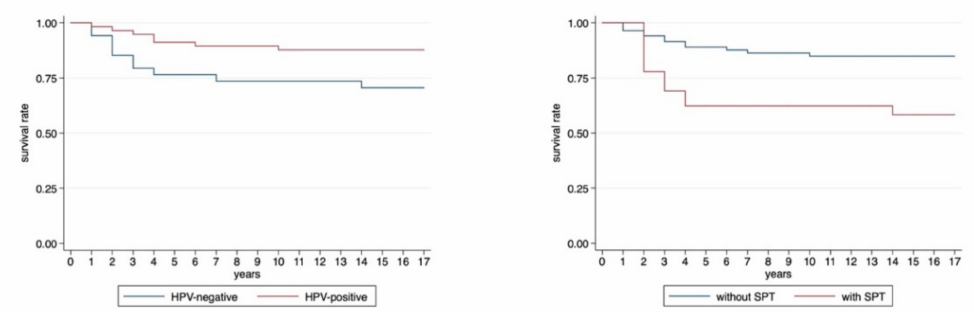
Figure 2. Kaplan–Meier survival plots of HPV-positive and HPV-negative patients. (Log-rank test: p -value = 0.037) and of patients with and without SPT (Log-rank test: p -value = 0.02). Five out of 21 (23.8%) OPSCC patients with SPT and 12/70 (17.1%) patients without SPT died. OPSCC patients without SPT had significantly better disease-specific survival than OPSCC patients with SPT (5-year survival 88.5% without SPT vs. 69.2% with SPT; Fisher’s exact test: p -value < 0.0001, Figure